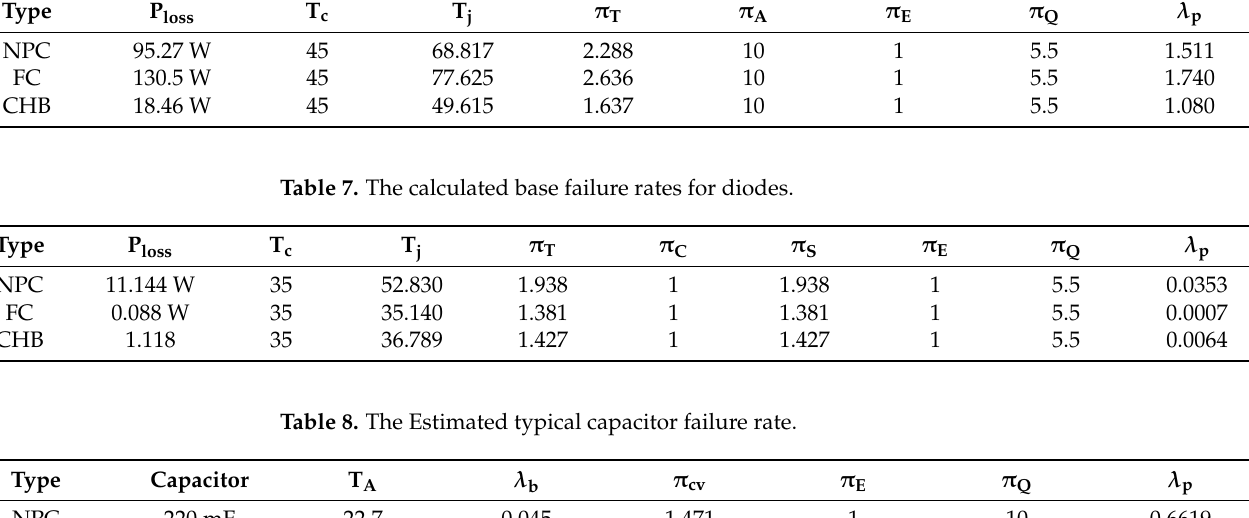
Table 6. The determined base failure rates of switches.